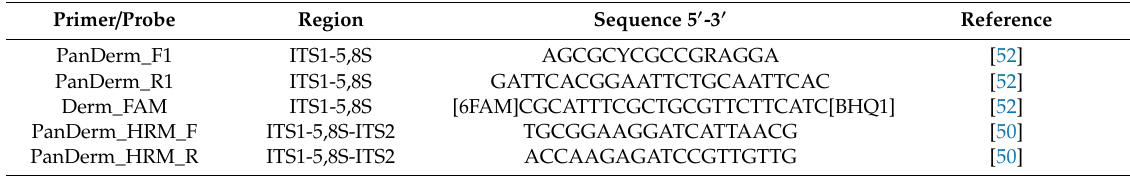
Table 1. Sequences of primers and probes used for real-time